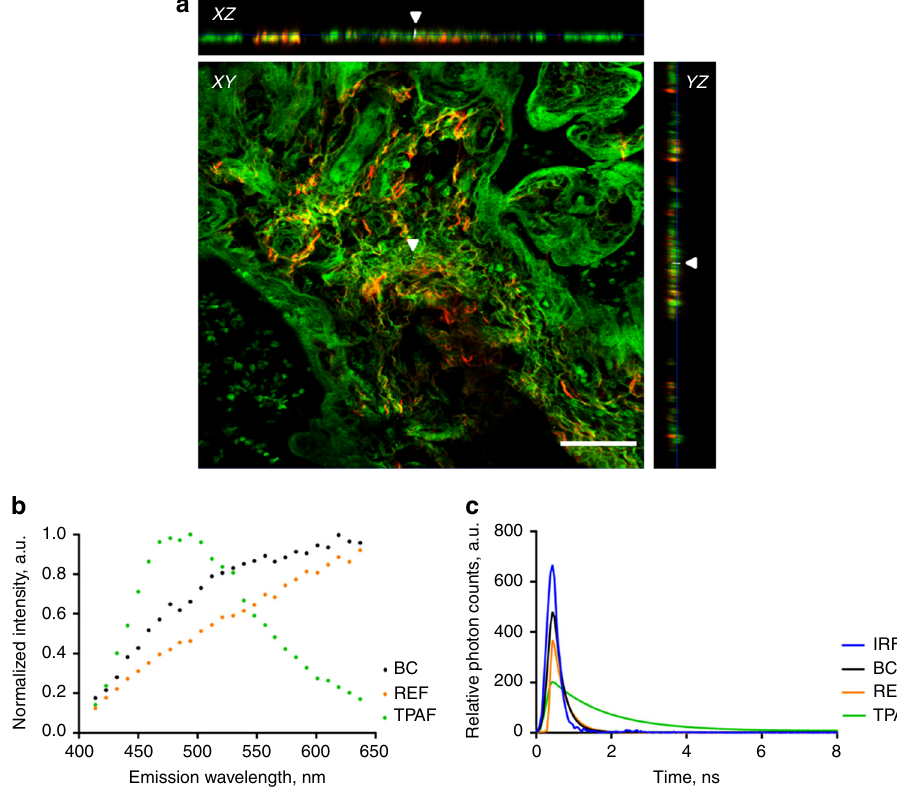
Fig. 3 Validation experiments to con fi rm the carbonaceous nature of the identi fi ed particles inside the placenta. a XY-images acquired throughout a placental section in the z -direction and corresponding orthogonal XZ-projections and YZ-projections showing a BC particle (white and indicated by white arrowheads) inside the tissue (red and green). Scale bar: 50 µ m. b Emission fi ngerprint of identi fi ed black carbon (BC), reference carbon black (REF) particles and two-photon excited auto fl uorescence (TPAF) under femtosecond pulsed illumination. c Temporal response of BC and REF particles and TPAF measured by time-correlated single photon counting. The instrument response function (IRF) overlaid in blue. Source data are provided as a Source Data fi